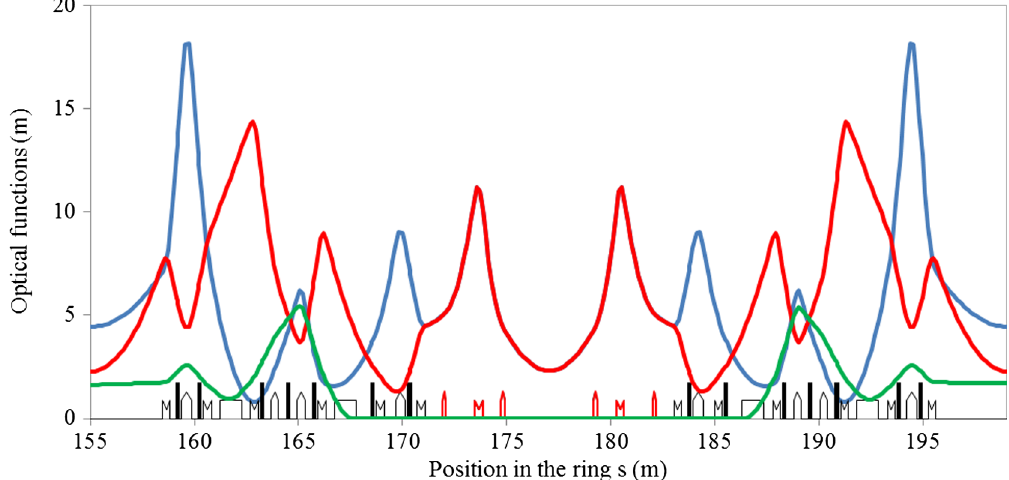
FIG. 2. Optical functions in the SDL09 straight section when the six additional skew quadrupoles are turned on. Magnetic structure: additional skew quadrupoles (up and down empty red arrows), dipoles (empty black rectangles), quadrupoles (up and down empty black arrows), sextupoles (black bars). Optical functions: horizontal beta (blue), vertical beta (red) and dispersion × 10 (green).